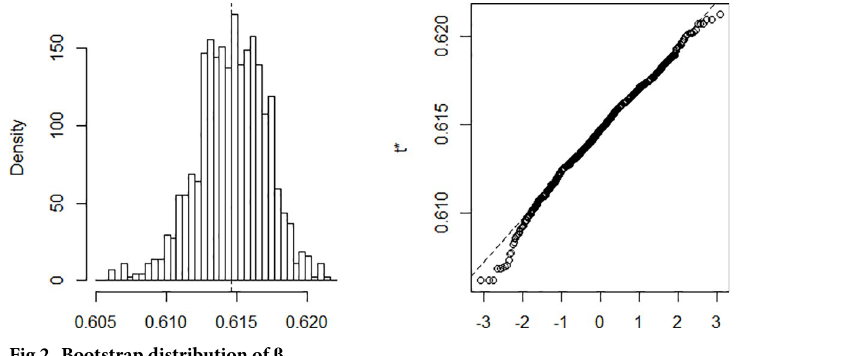
Fig 2. Bootstrap distribution of β .